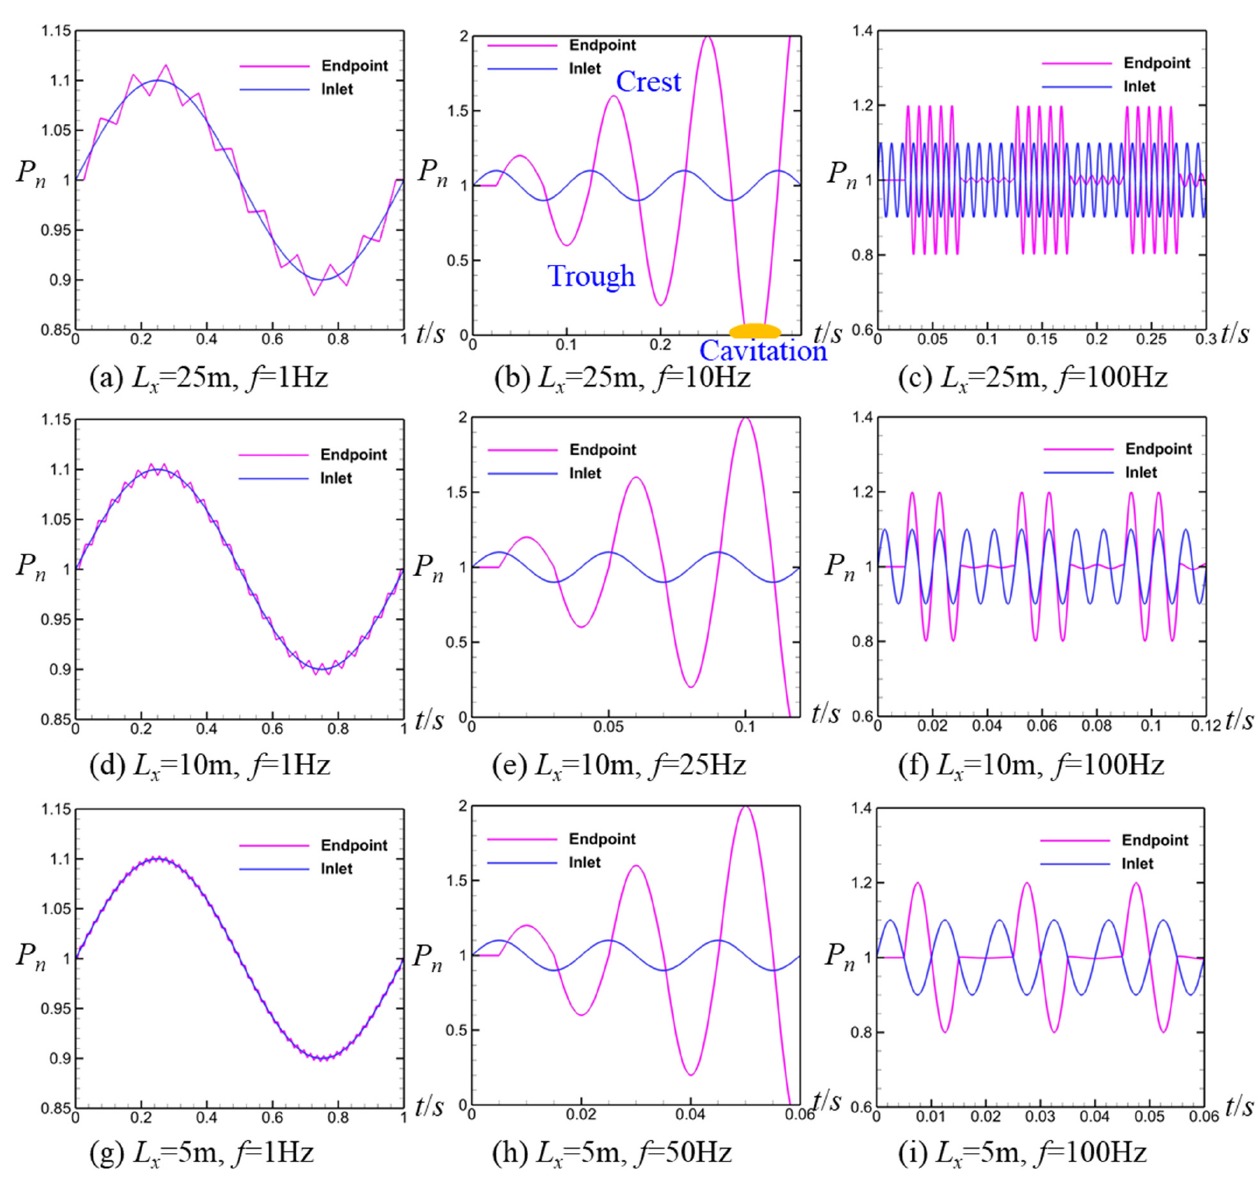
Figure 5. Normalized pressure–time P n - t curves at inlet and endpoint: ( a ) L x = 25 m, f = 1 Hz; ( b ) L x = 25 m, f = 10 Hz; ( c ) L x = 25 m, f = 100 Hz; ( d ) L x = 10 m, f = 1 Hz; ( e ) L x = 10 m, f = 25 Hz; ( f ) L x = 10 m, f = 100 Hz; ( g ) L x = 5 m, f = 1 Hz; ( h ) L x = 5 m, f = 50 Hz; ( i ) L x = 5 m, f = 100 Hz. All normalized pressures are dimensionless quantities.